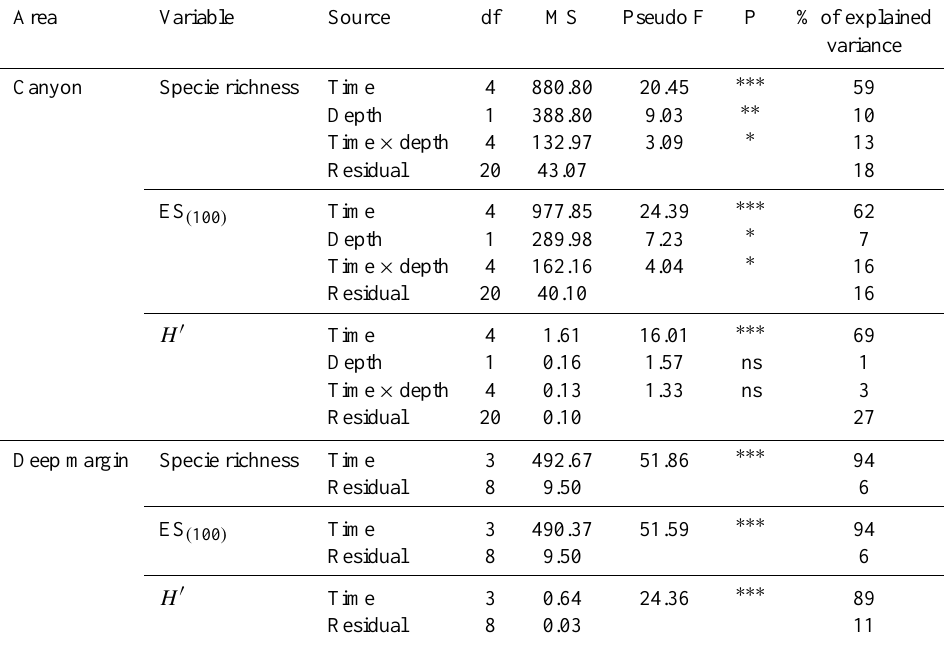
Table 4. Results of the PERMANOVA tests on nematodes biodiversity, estimated as species richness, expected species number (ES ( 100 ) ) and H 0 values in the sediments of the Cap de Creus Canyon and deep margin. Also reported is the percentage of variance explained by each source of variation and their interaction. df = degrees of freedom; MS = means square; F = statistic F; P = probability level. ∗∗∗ = P < 0.001; ∗∗ = P < 0.01; ∗ = P < 0.05; ns = not significant.